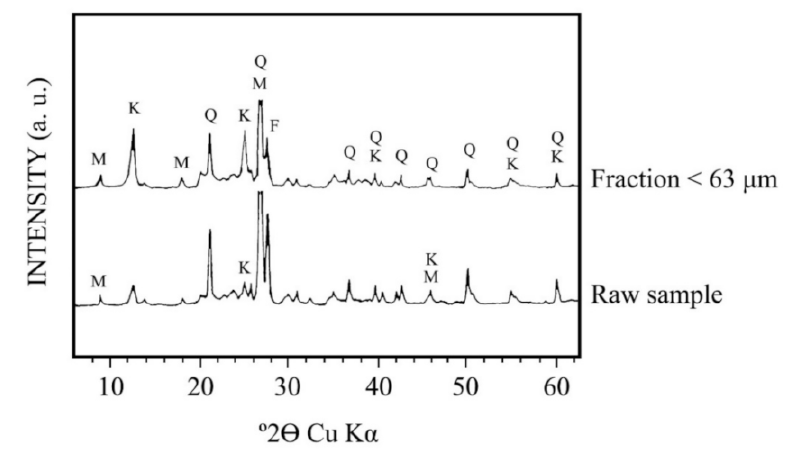
Figure 4. Mineralogical composition by XRD of the raw kaolin sample and fraction < 63 µ m obtained by wet sieving. M = muscovite; Q = quartz; F = feldspar (microcline); K = kaolinite. Table 1. Results of the mineralogical analysis of the samples: semiquantitative estimation of the minerals identified by XRD (in wt %). Sample Kaolinite Quartz Feldspar Muscovite Raw kaolin sample 20 30 35 15 Fraction under 63 µ m 50 20 10 20 Kaolin of Burela 85